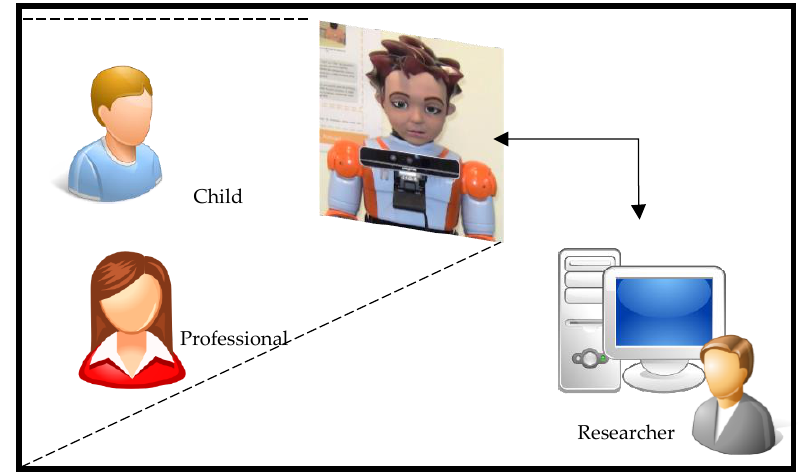
Figure 5. Experimental configuration: Child – ZECA – Professional – Researcher.